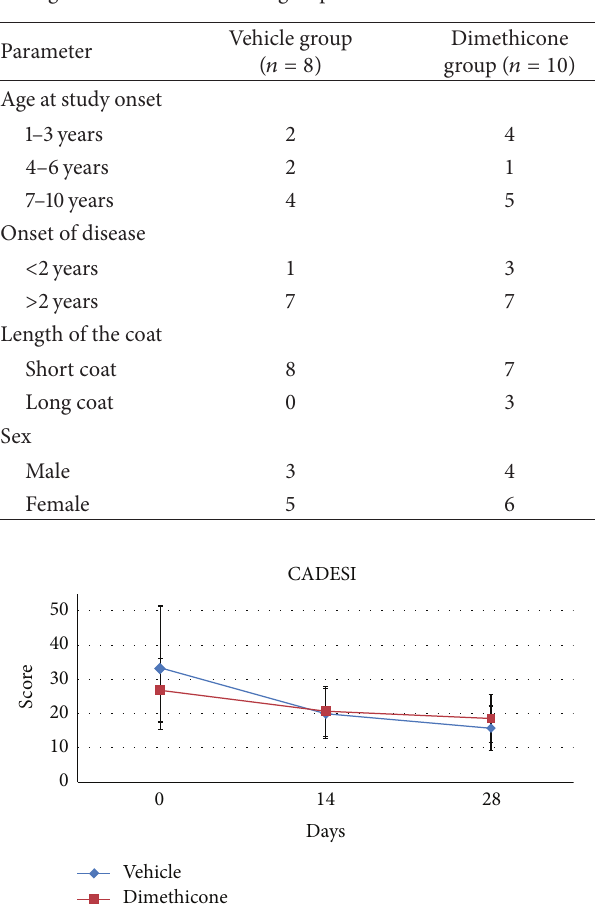
Table 1: Allocation of the dogs between the vehicle group and dimethicone group according to age, onset of disease, length of the coat, and sex. Based on these parameters, the distribution was homogeneous between the two groups.